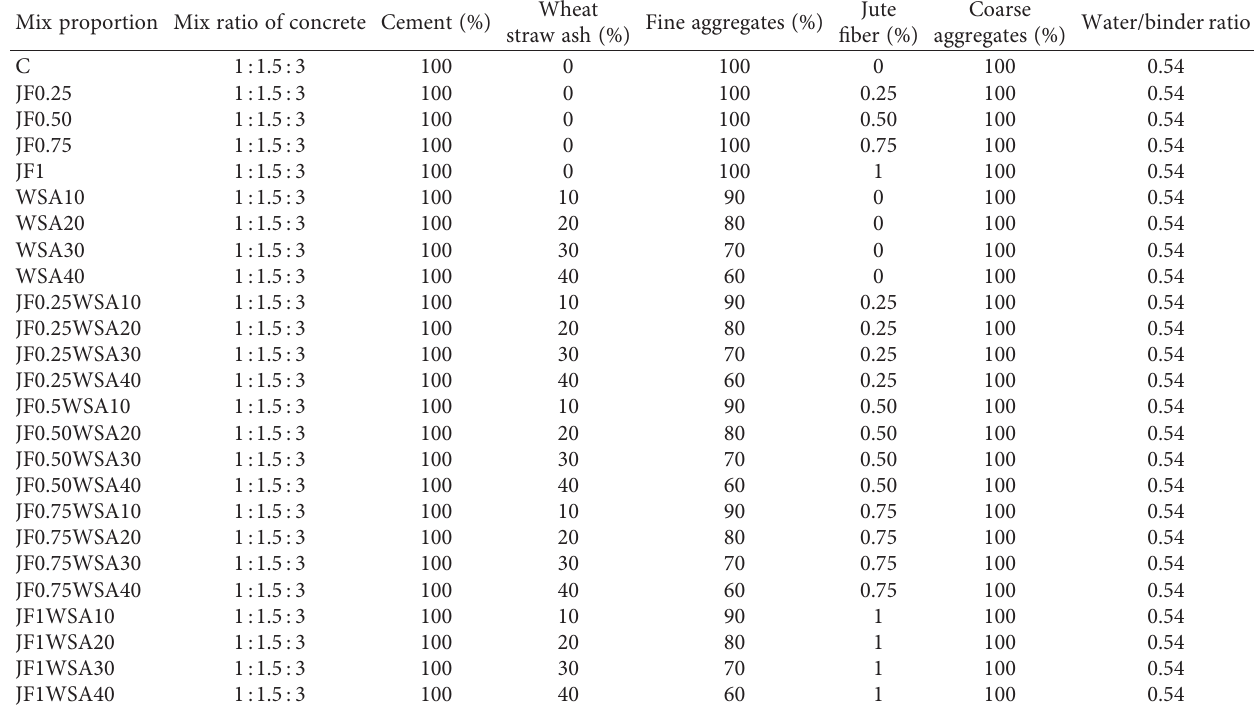
Table 3: Mix proportion for